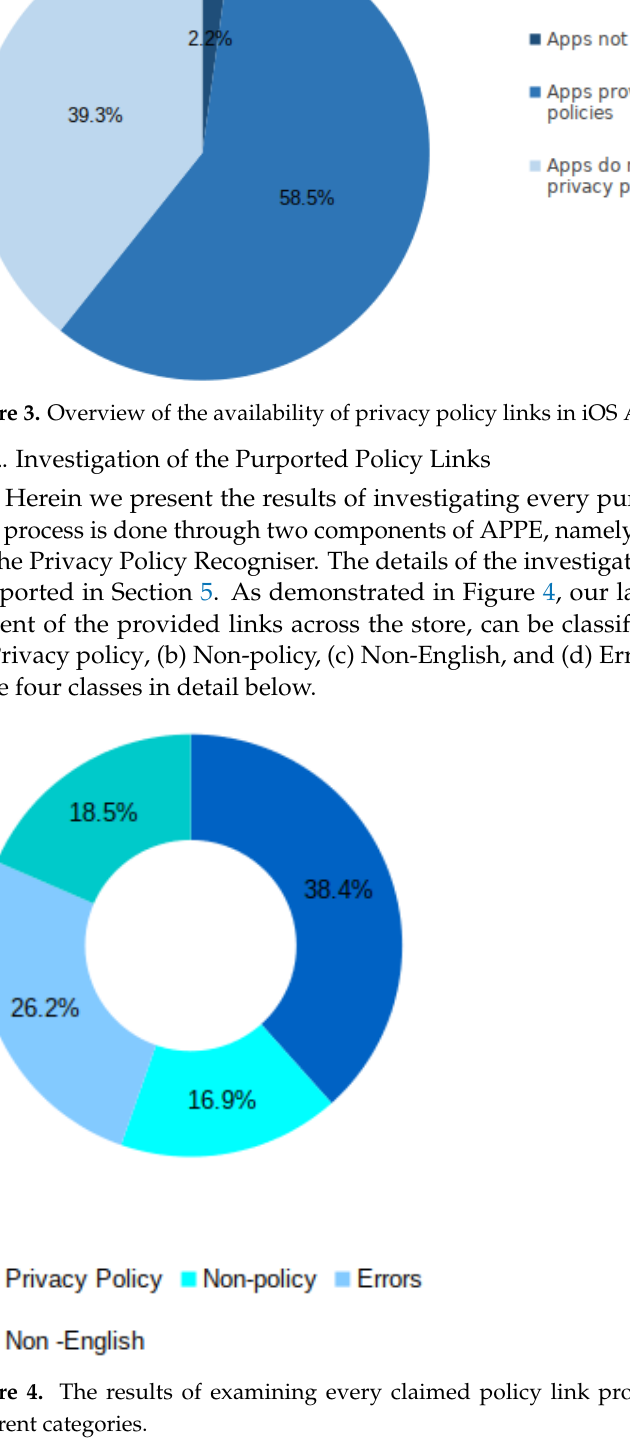
Figure 4. The results of examining every claimed policy link provided by the apps across the different